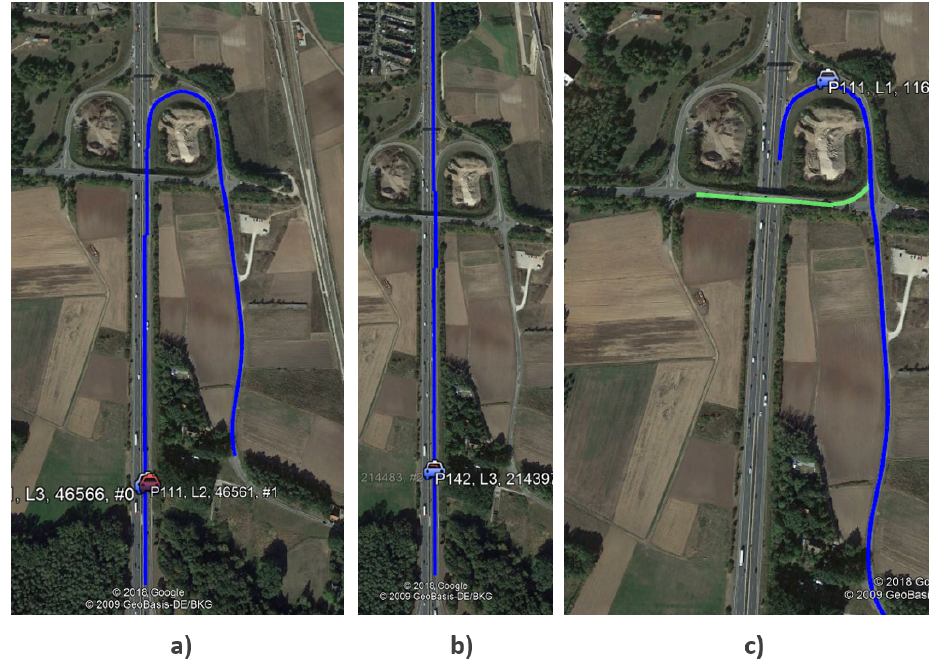
Figure 11. Comparison between different MPP computation methods. ( a ) Ground truth. ( b ) Prediction given by a classical (non-AI) method. ( c ) Correctly predicted path using an AI Inference Engine.